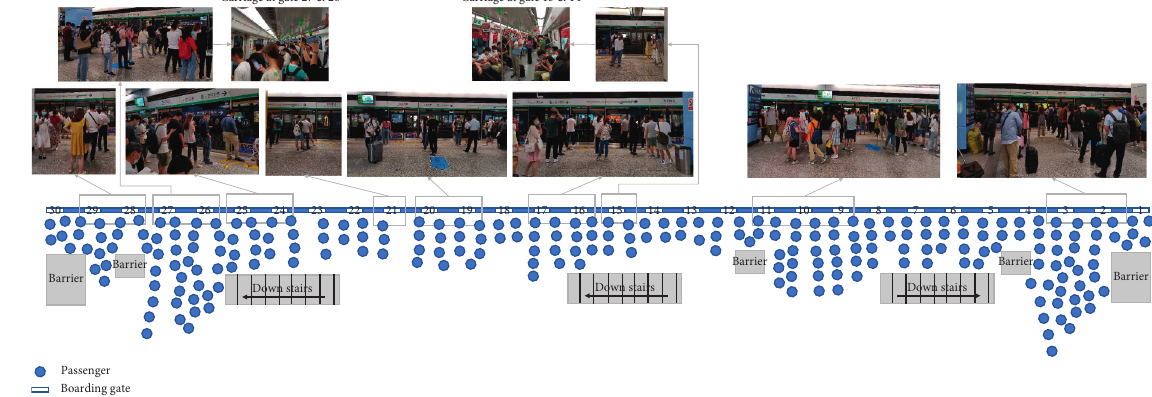
Figure 1: Distribution of passengers on the metro station